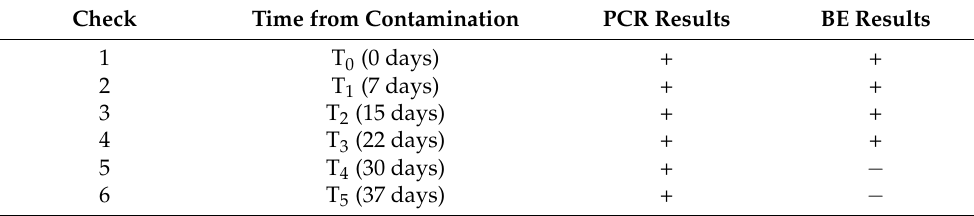
Table 4. Results of the tests related to the second experimental